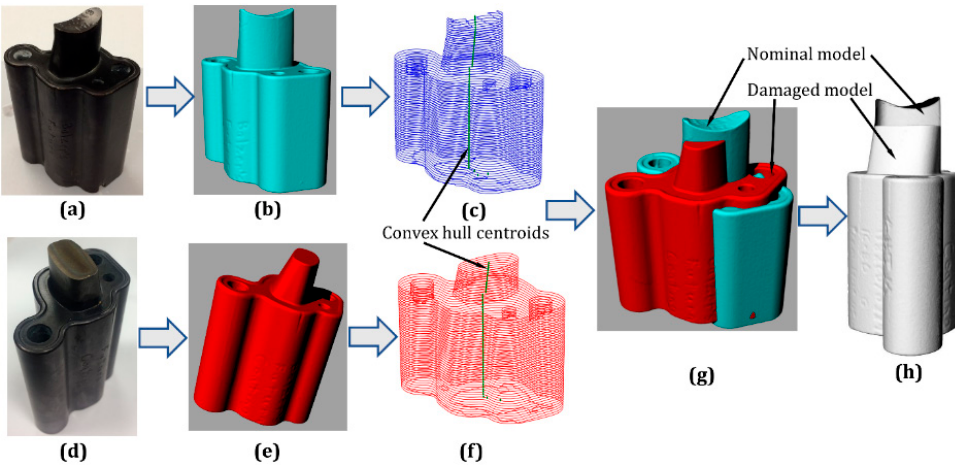
Figure 14. Model alignment. ( a ) Nominal part; ( b ) nominal model; ( c ) cross-sections of the nominal model; ( d ) damaged part; ( e ) damaged model; ( f ) cross-sections of the damaged model; ( g ) models before alignment; ( h ) models after alignment.